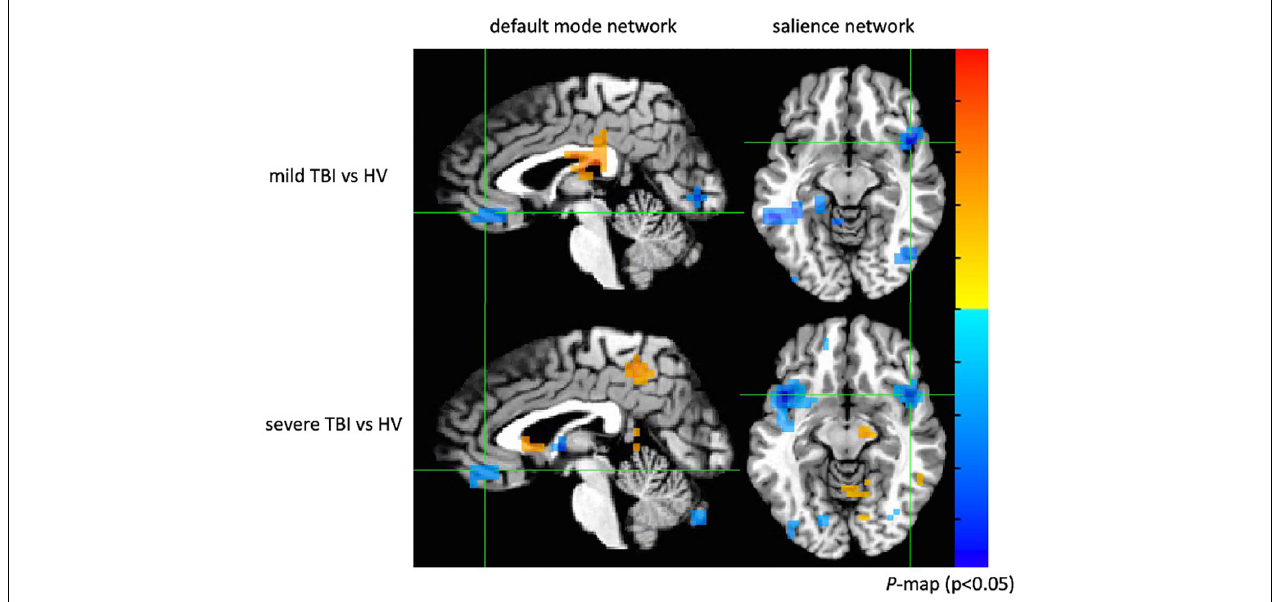
FIGURE 14 | Group comparison between mild TBI, severe TBI and healthy subjects. Both mild and severe TBI groups showed significantly decreased connectivity in the ventromedial prefrontal cortex ( p < 0.05) of the default mode network and decreased connectivity in the insular cortex ( p < 0.05) of the salience network.